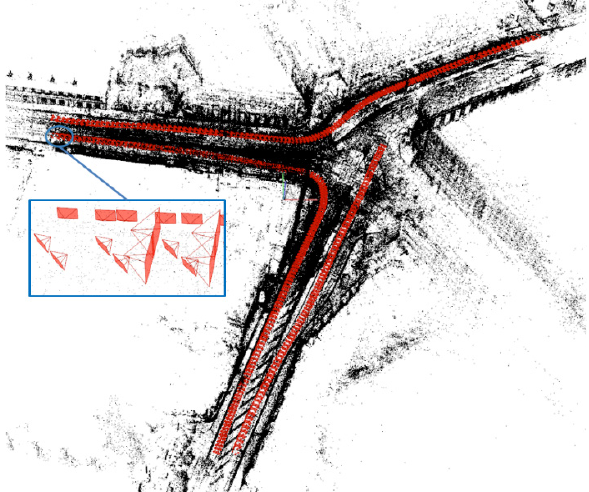
Figure 5. Georeferenced mobile mapping images (red) and 3D tie points (black) at our outdoor test site using our modified COLMAP processing